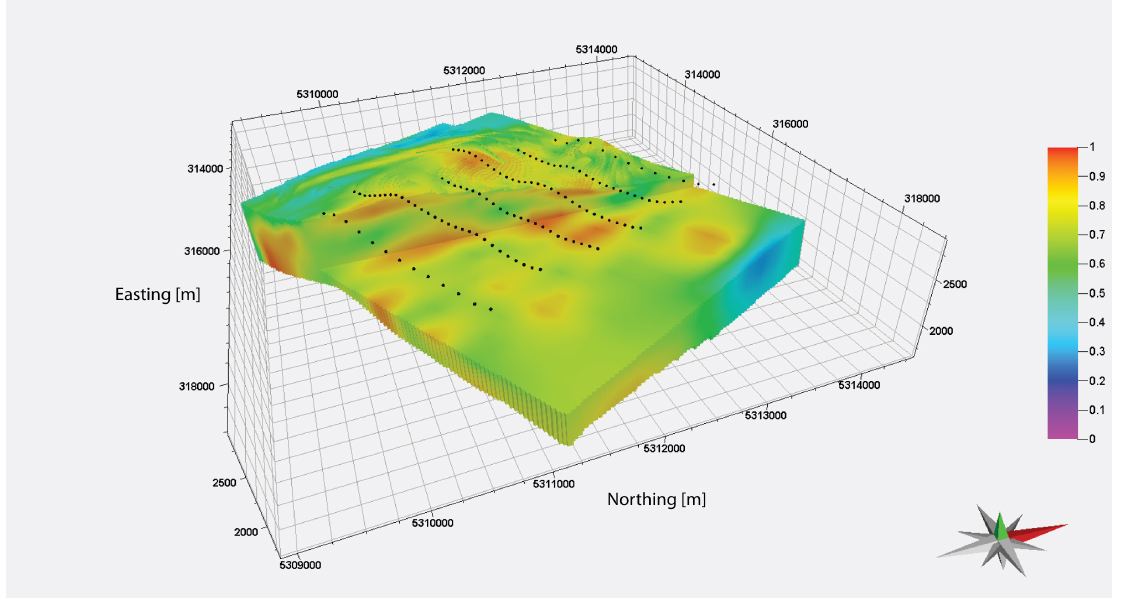
Figure 11. A 3D view of the 3D relaxation parameter model recovered from 3D inversion of pole–dipole IP